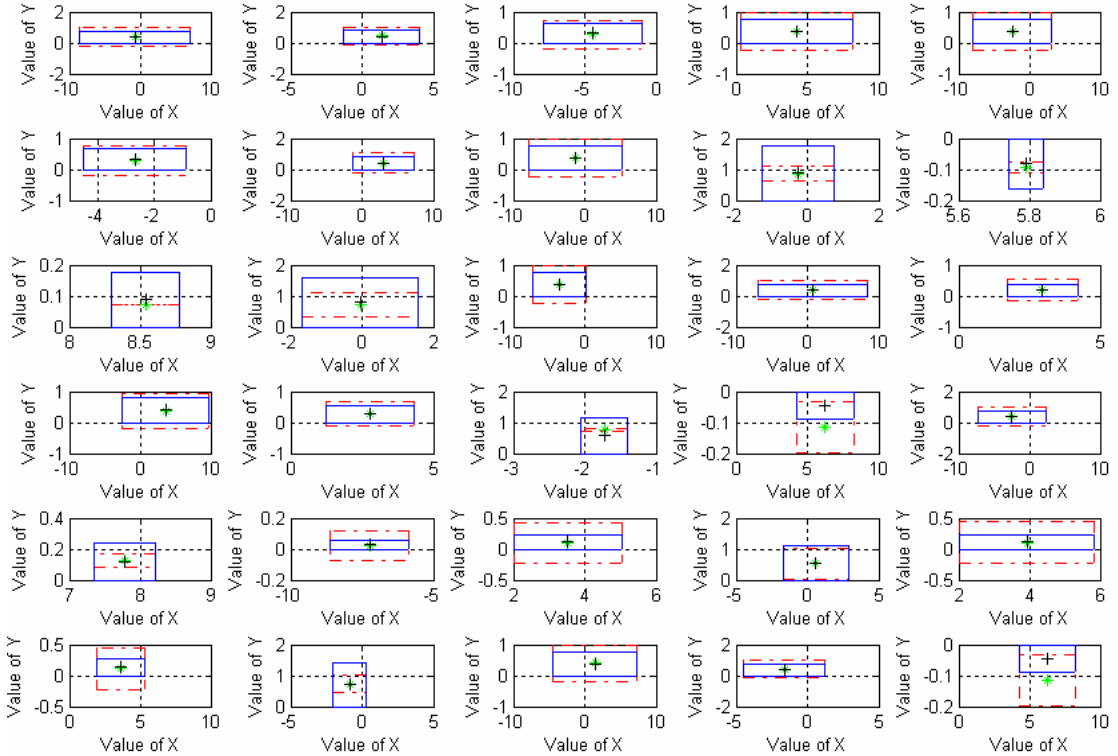
Fig.2. This is comparisons between predicted intervals and real ones used by Sinc